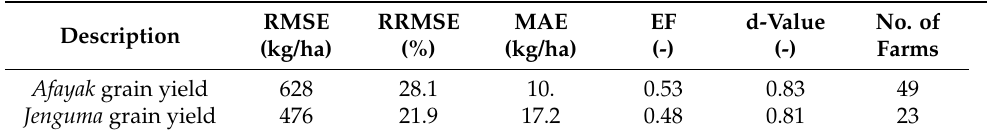
Table 4. Model evaluation statistics at maturity for grain